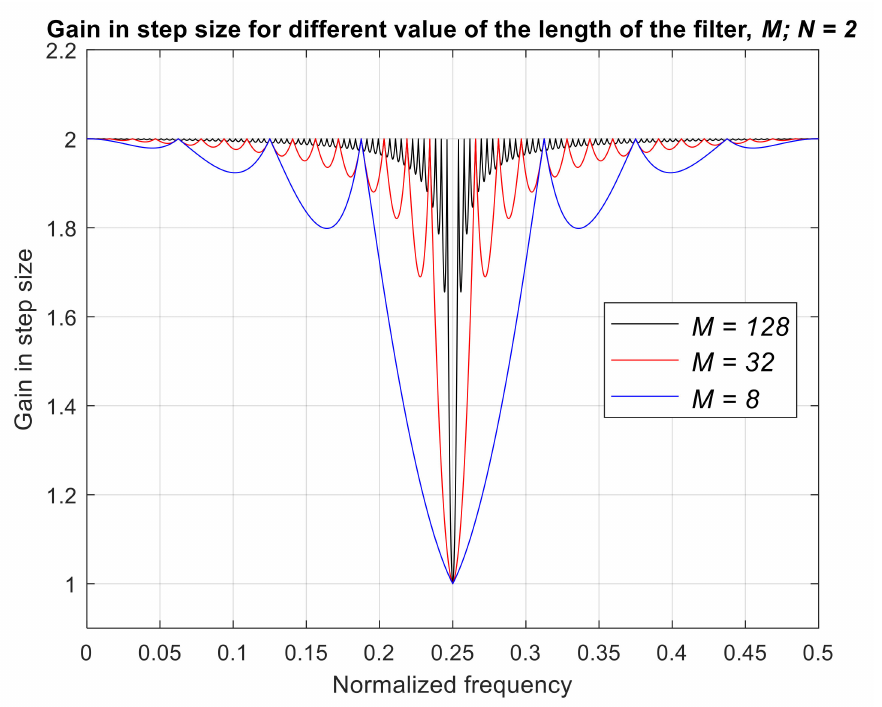
Figure 3. Gain in step-size with filter lengths, M = 8, 32, and 128 for a single tone. The decimating factor is set to N =